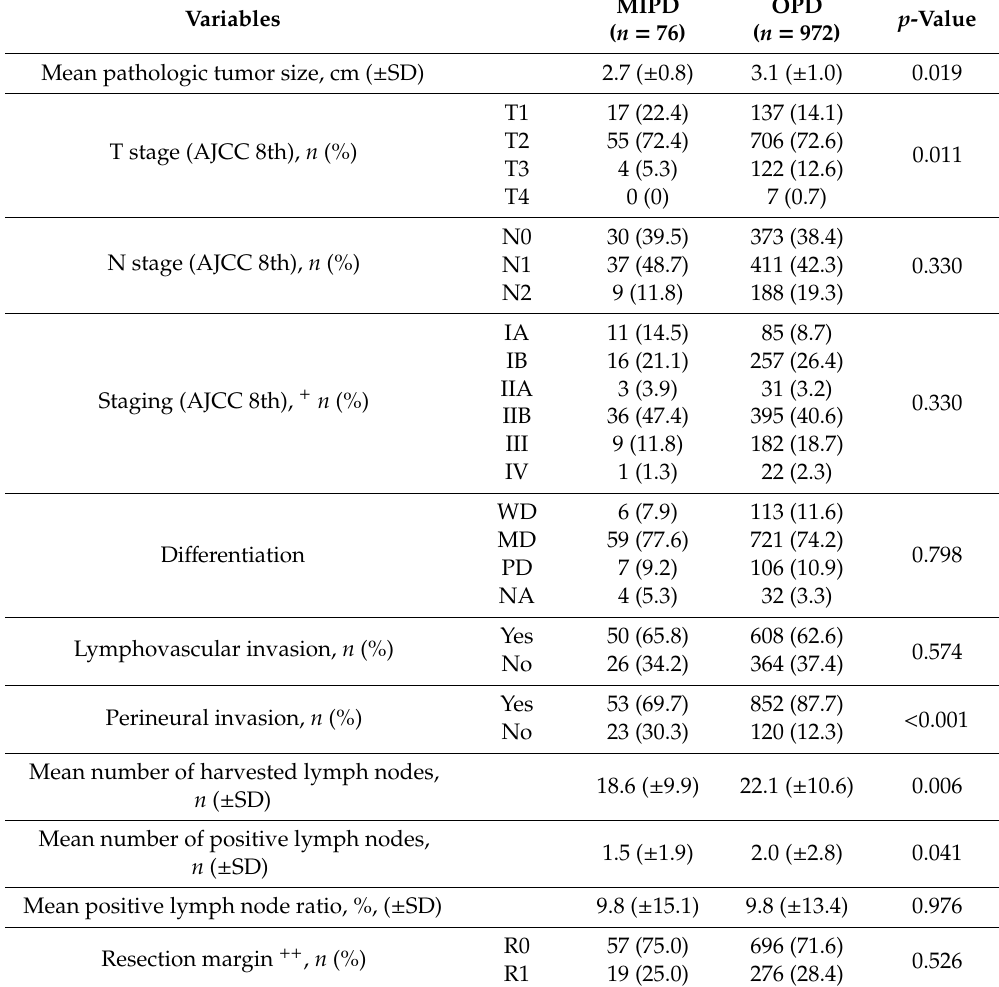
Table 3. Pathologic outcome according to surgical method of pancreaticoduodenectomy.